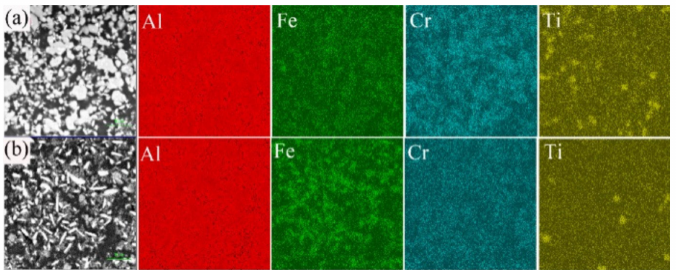
Figure 8. Al, Fe, Cr, Ti element EDS mapping of ( a ) flake phase and ( b ) acicular phase of samples with sintering temperature of 640 ◦